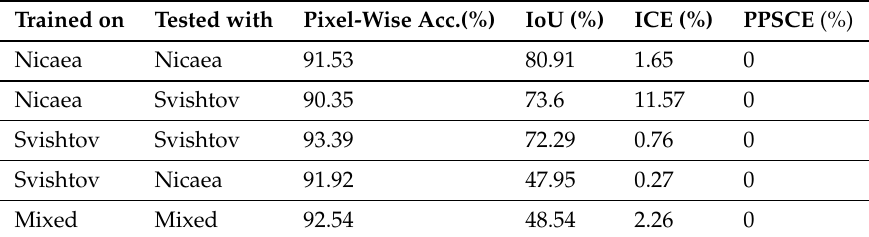
Table 2. Results with different metrics are presented for five different models.